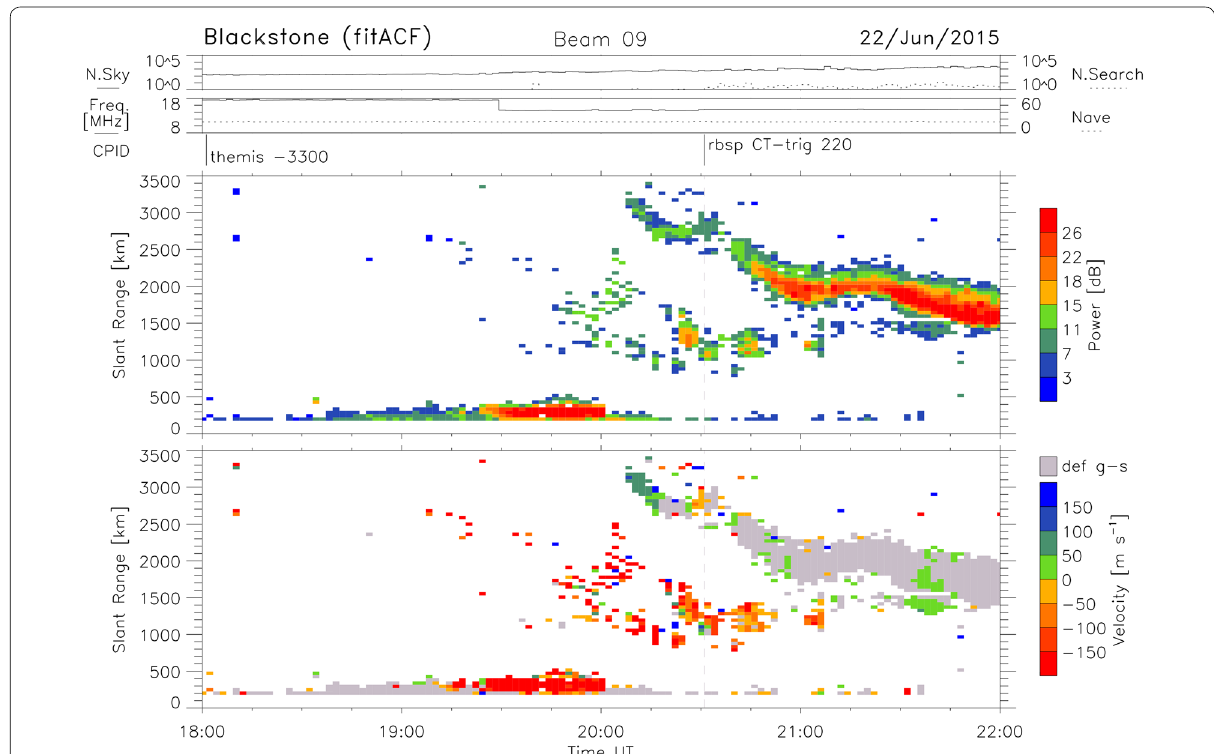
Fig. 7 Range-time plots of the echo power (upper panel) and line of sight velocity (lower panel) measured by the beam 09 of the Blackstone SuperDARN radar. The radar detected the anti-sunward flows (green) during the period of the impulsive electric field